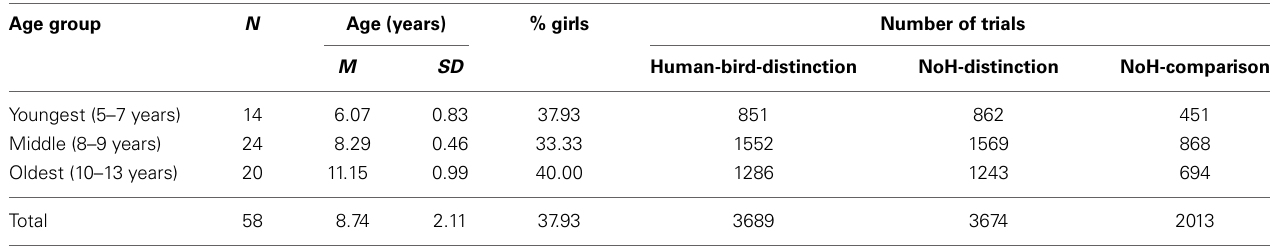
Table 1 | Population characteristics and number of trials obtained per age group and paradigm. Age group N